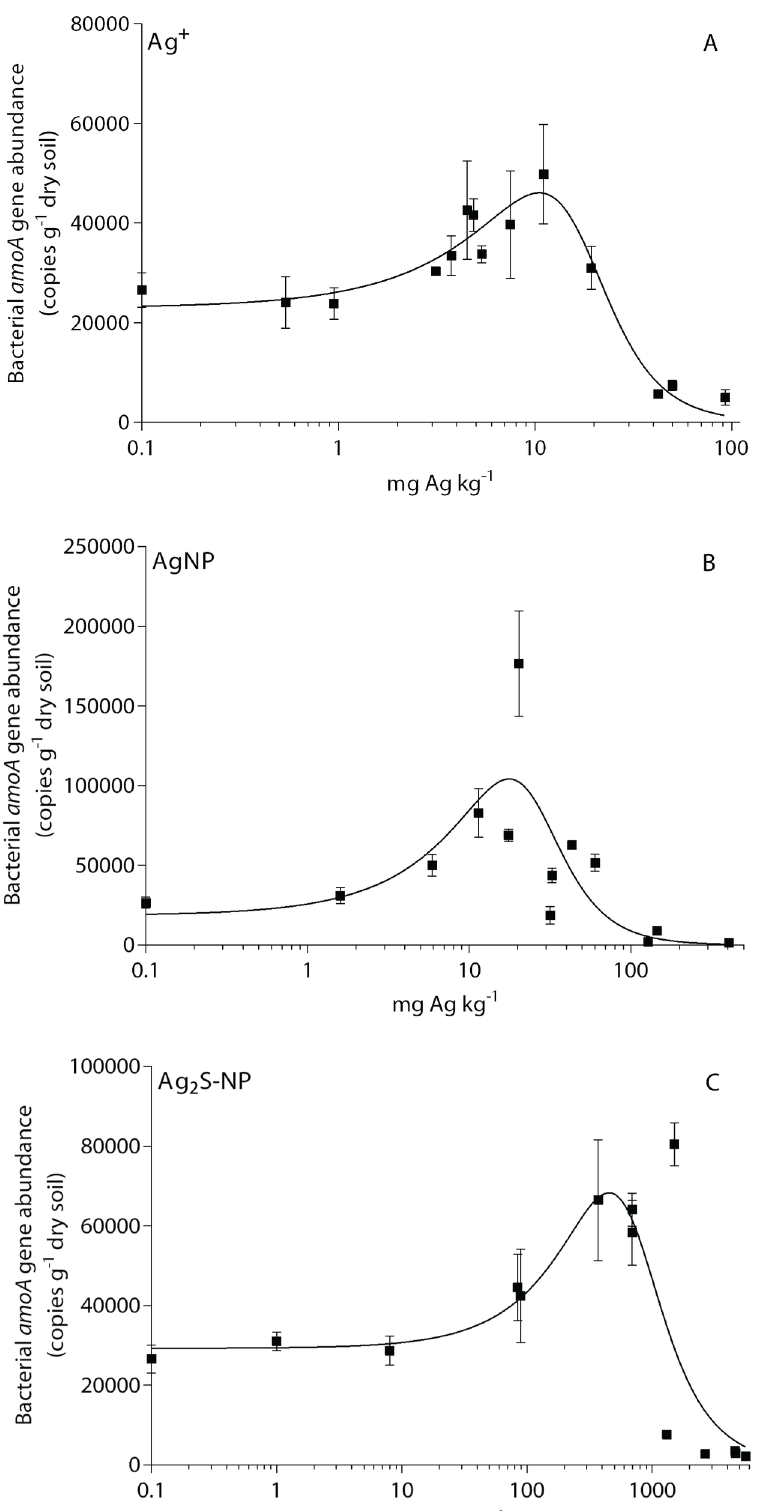
Fig 3. Dose-response curves showing the decrease in total abundance of bacterial amo A gene over 28 d. Results are shown for each Ag treatment: (A) ionic Ag (Ag + ), (B) Ag nanoaparticles (AgNP) and (C) Ag